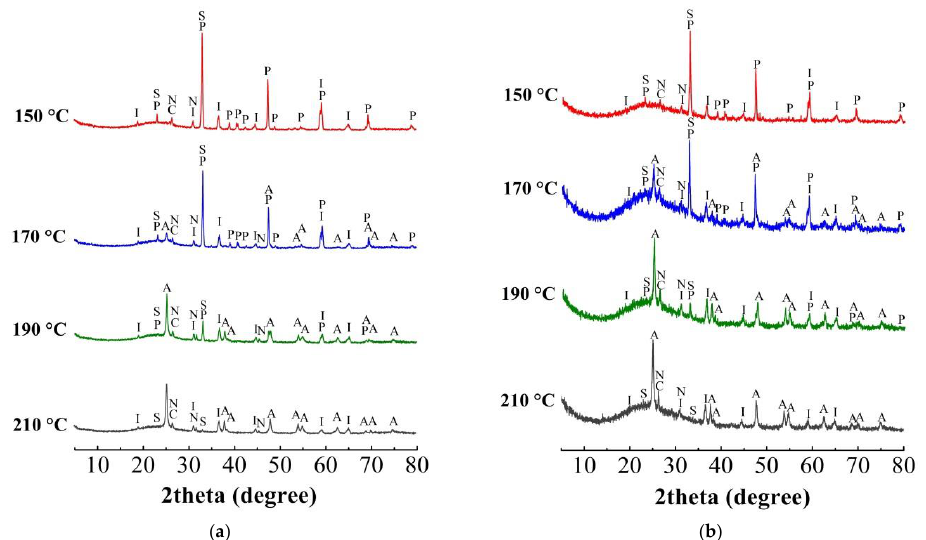
Figure 3. The effect of leaching temperature on the XRD patterns of the IDBR high-pressure leaching residues by 10% HCl at L/S ratio = 11/1 for 0 ( a ) and 15 min ( b ); P — perovskite (CaTiO 3 ); A — anatase (TiO 2 ); I — spinel (MgAl 2 O 4 ); S — sulfur (S 8 ); C — graphite (C); N — halite (NaCl). As can be seen from the XRD patterns, the main crystalline phases at all temperatures are perovskite, anatase, and spinel. The proportion of anatase, which is one of the poly- morphic modifications of titanium dioxide, increases with a temperature rise; at the same